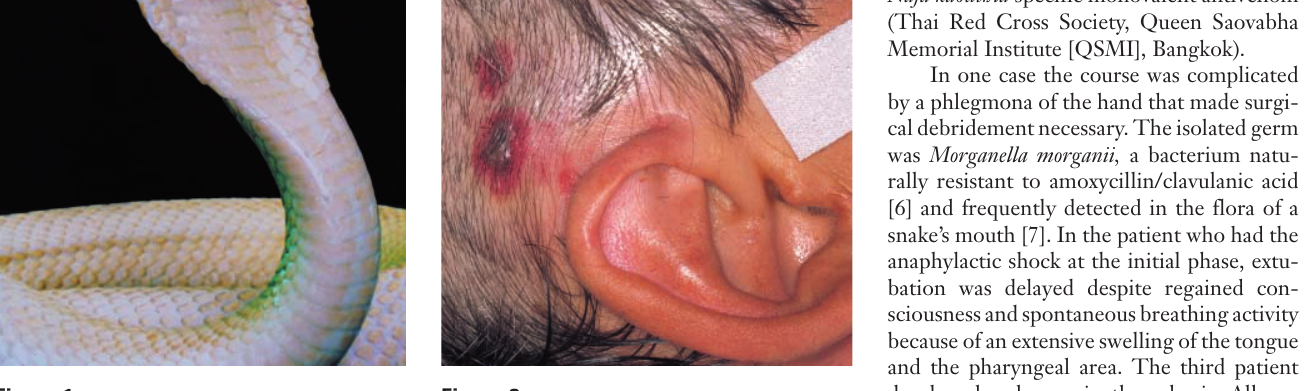
Photograph of Naja kaouthia taken by Patient 3 immediately before he was bitten.